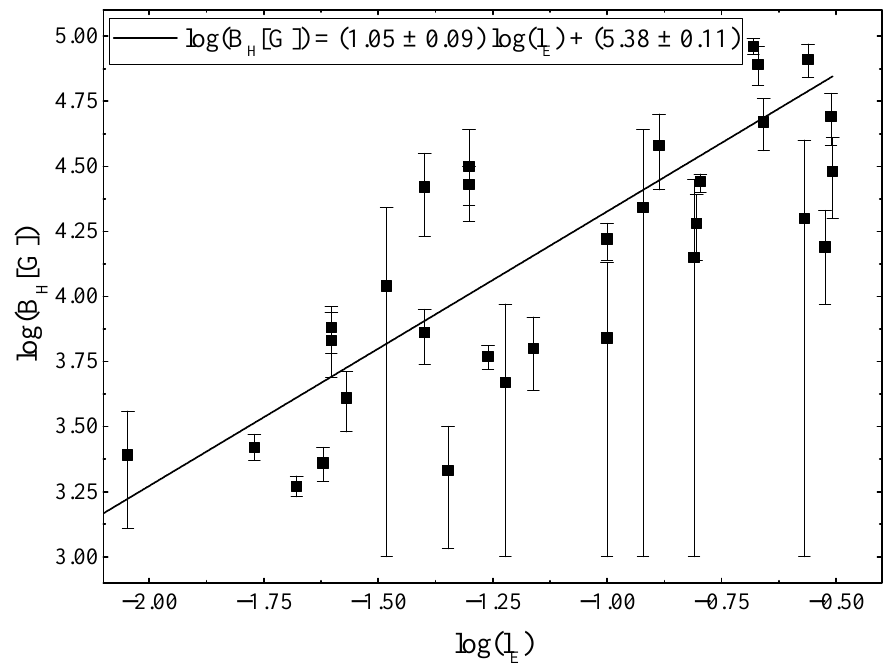
Figure 10. Dependence of the magnetic field intensity B H on the Eddington ratio l E